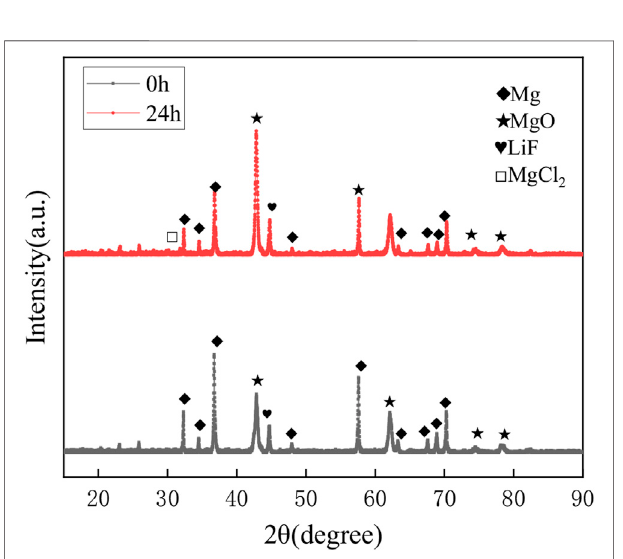
FIGURE 4 | Cross-section morphologies of the specimens in 3.5% NaCl solution.